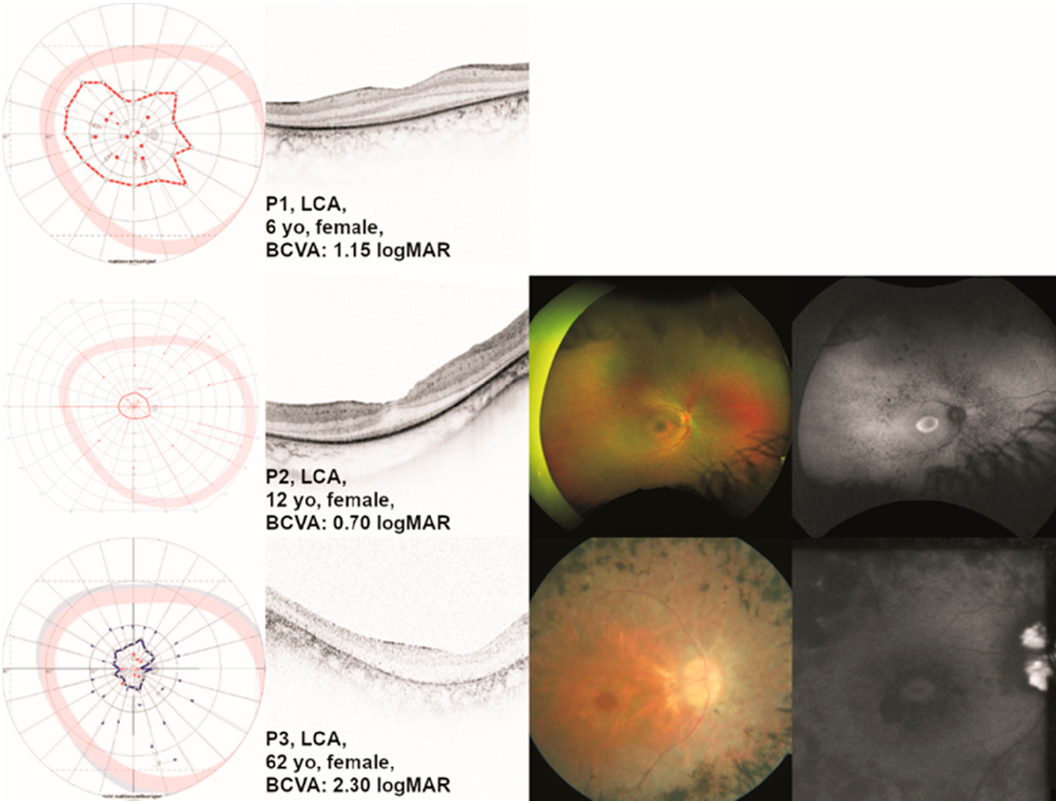
Figure 1. Clinical presentation of patients with TULP1 -associated Leber congenital amaurosis (LCA). One eye per patient is listed by age at examination from top to bottom including (where available) the results of kinetic visual field (VF) testing, optical coherence tomography (OCT), fundus photography, and fundus autofluorescence (FAF) imaging. Gender and best-corrected visual acuity (BCVA) are also listed. Note the visible but altered ellipsoid zone (EZ line) on OCT in the two youngest patients (P1 and P2) compared to the older patient (P3), where the EZ line is no longer visible with outer retinal atrophy. Additionally, note the paracentral hyperautofluorescent ring on FAF in patient P2, whereas patient P3 shows paracentral hypoautofluorescence as in paracentral atrophy.